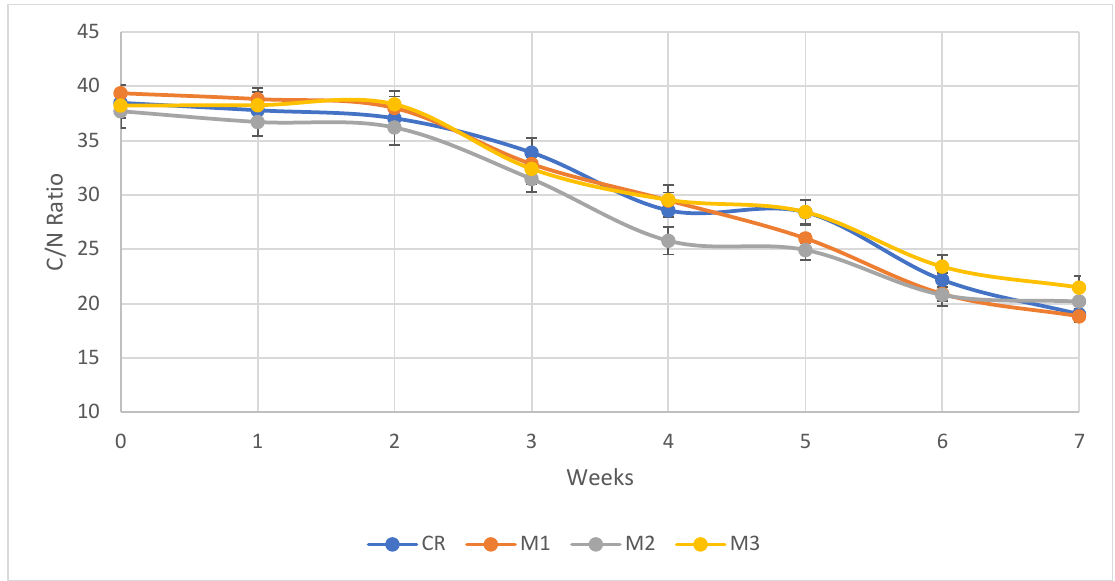
Figure 12. C/N ratio behavior in mixtures (CR, M1, M2 and M3) during the vermicomposting process.